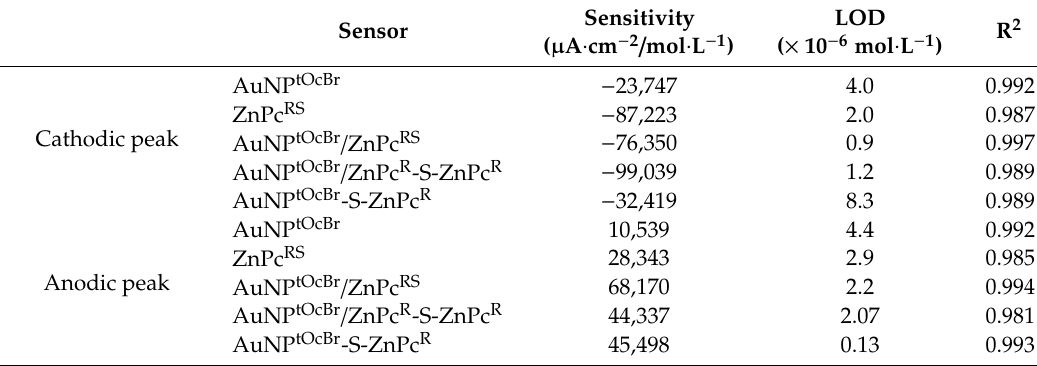
Table 3. Sensitivity, limit of detection (LD) and correlation coe ffi cient (R 2